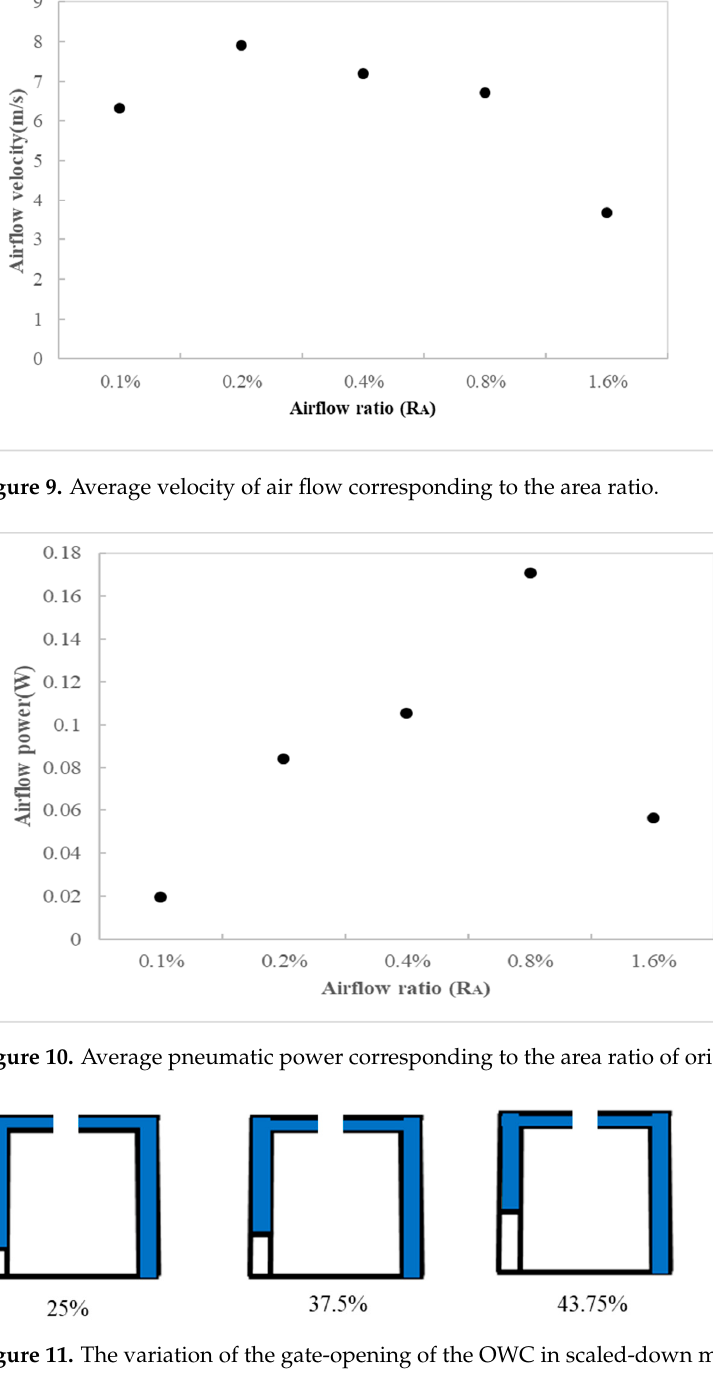
Figure 11. The variation of the gate-opening of the OWC in scaled-down model structure.